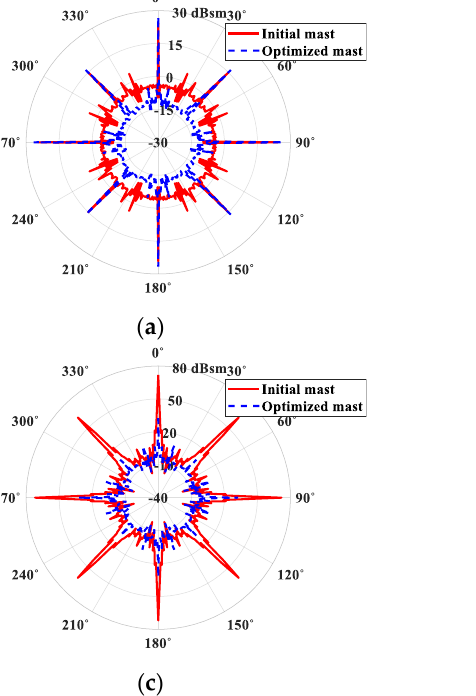
Table 1. Geometric mean of the integrated mast. (Unit: dBsm)